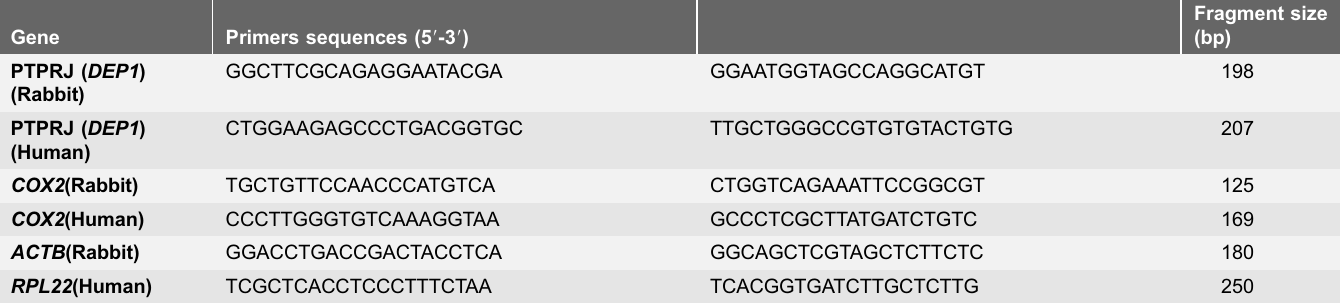
Table 1. Primers used for the real time